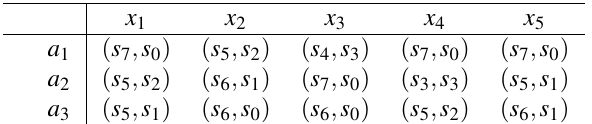
Table 5. Decision matrix R 1